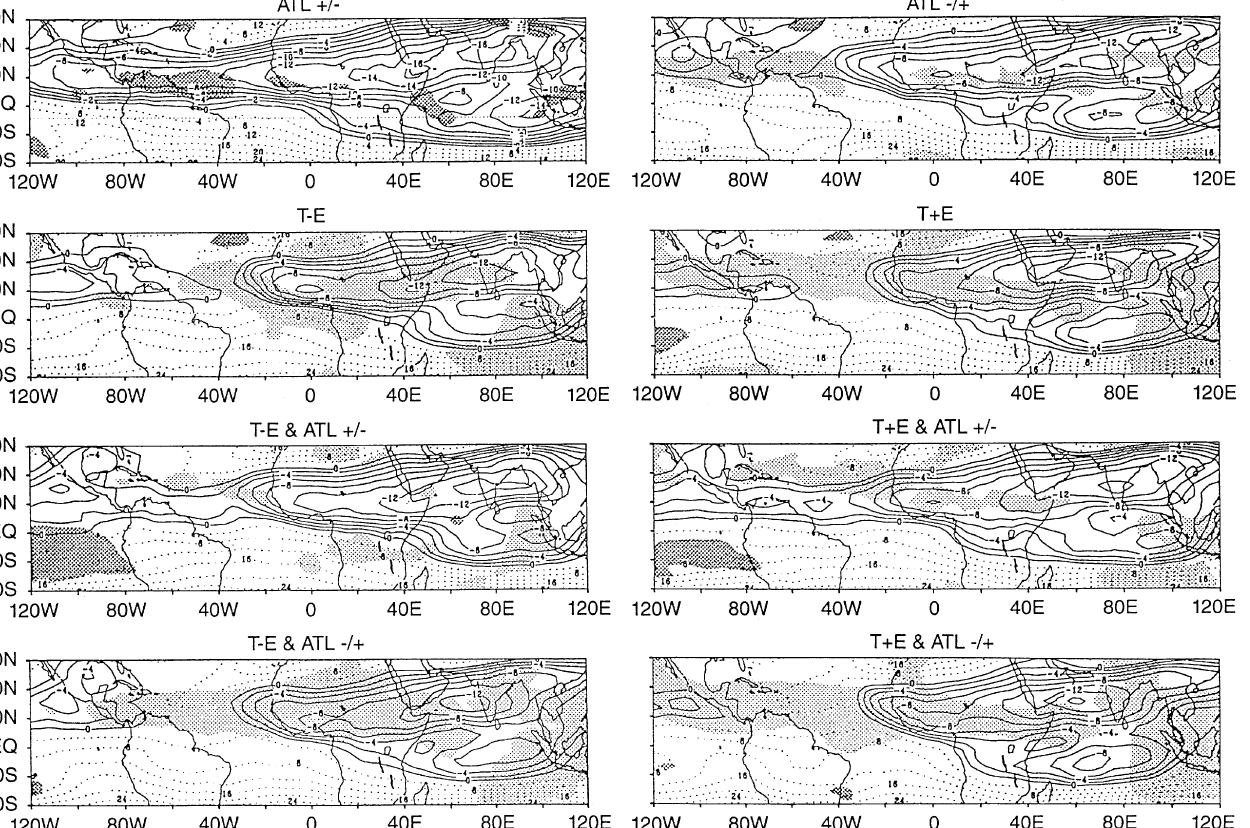
itive (negative) anomaly areas significant at the 5% level are shaded in light ( dark )